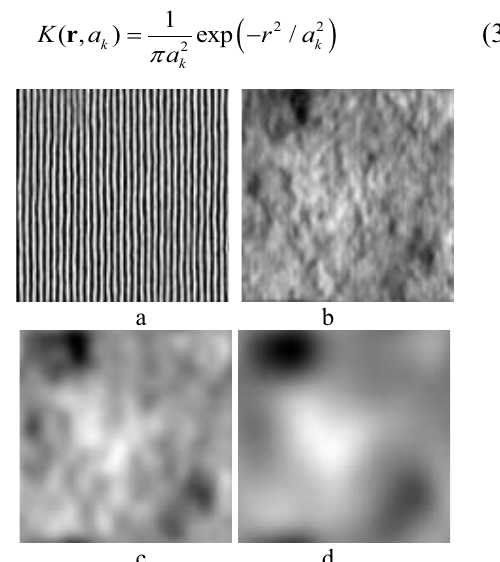
Fig.2. (a) Object image and its quality map in a turbulent medium at different values of the smoothing coefficient: (b) a k =0.7 a t , (c) 2.5 a t ,